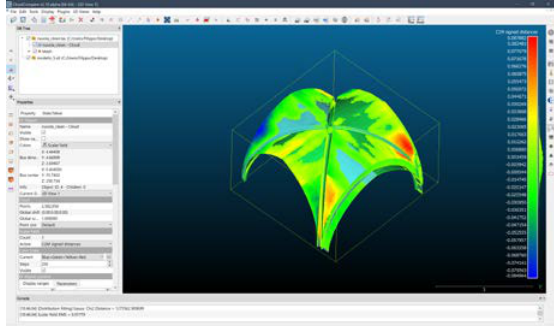
Figure 9. Graphic of standard deviation between point clouds and the model of rib vault